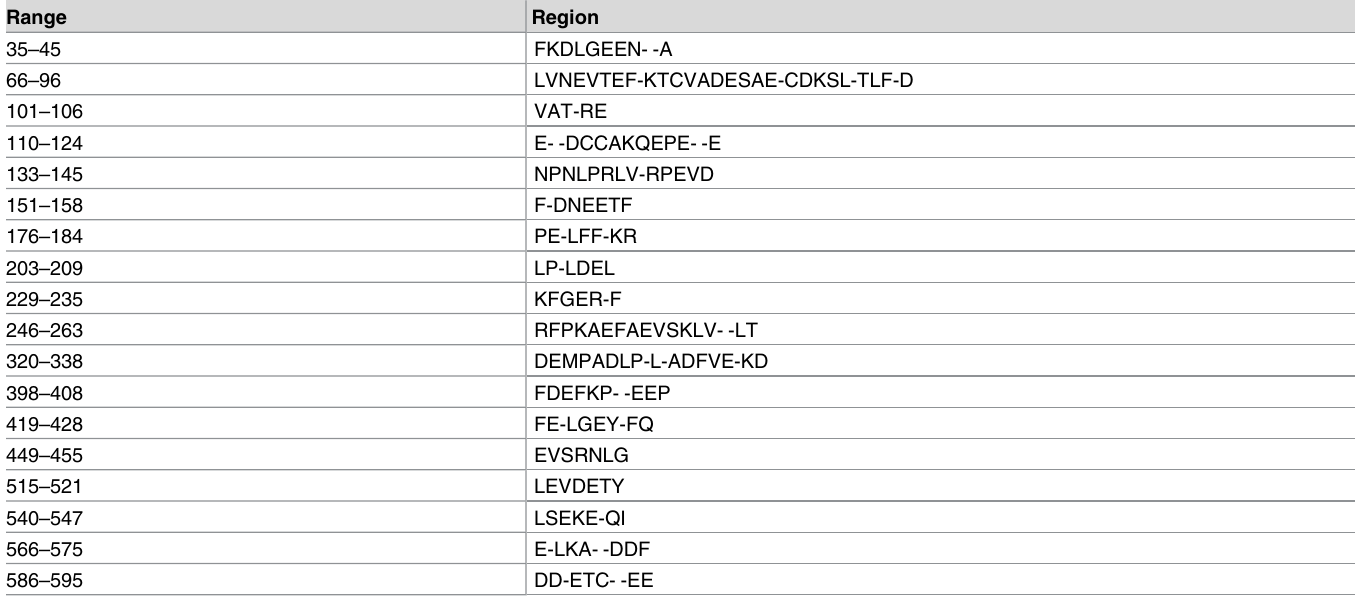
Table 2. HSA epitopes. Table showing18 HSA epitoperegions identifiedby the algorithm.Dashes mark gaps of residues with no selectivity. The regions were identified from the logo plots, and definedas having a minimumof 4 residues and a maximum gap-lengthof 2 residues.